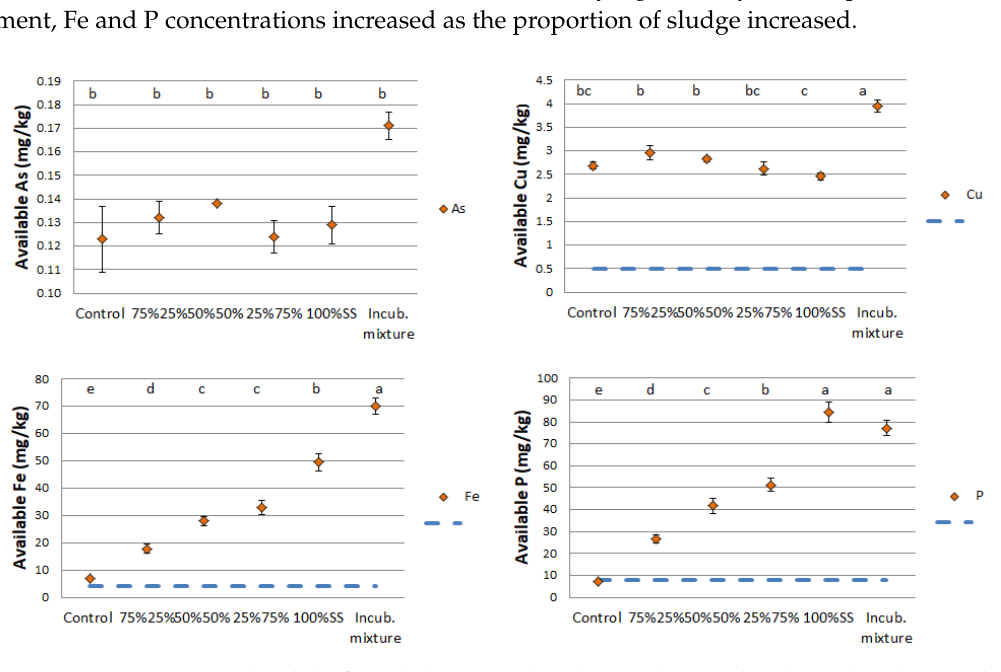
Incubated mixture